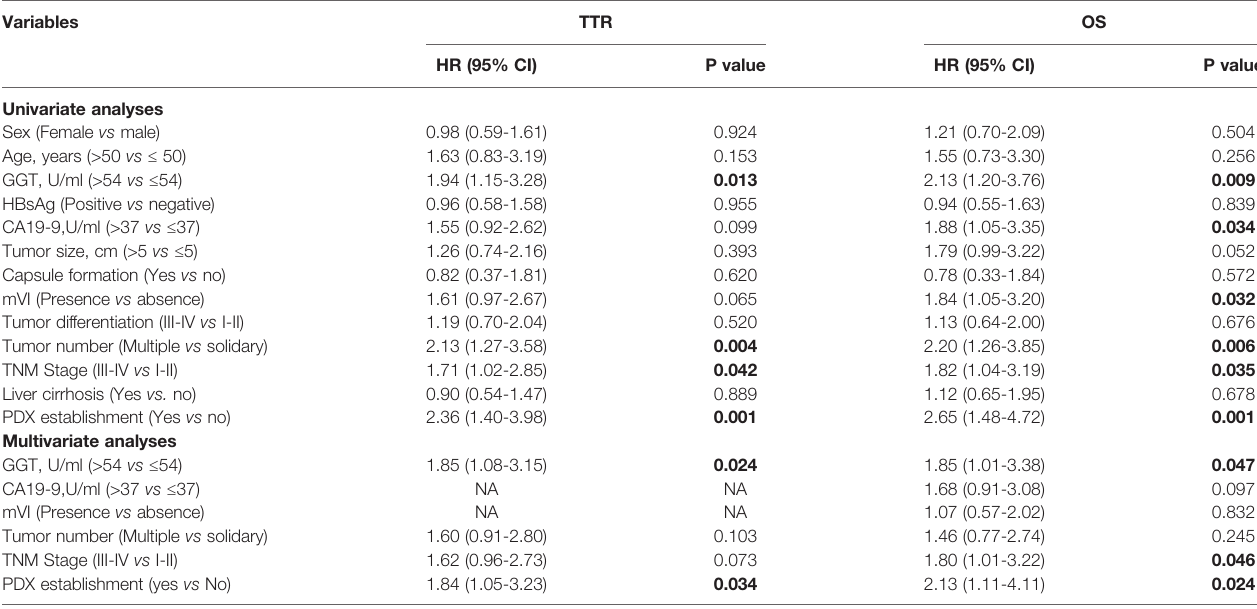
TABLE 2 | Univariate and multivariate analyses showed PDX establishment as an independent predictor for TTR and OS. Variables TTR OS HR (95% CI) P value P value Univariate analyses Sex (Female vs male)